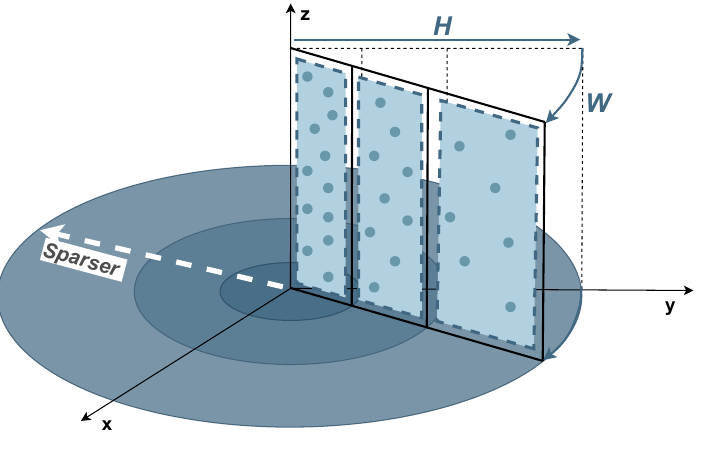
Figure 17. BEV sector partition